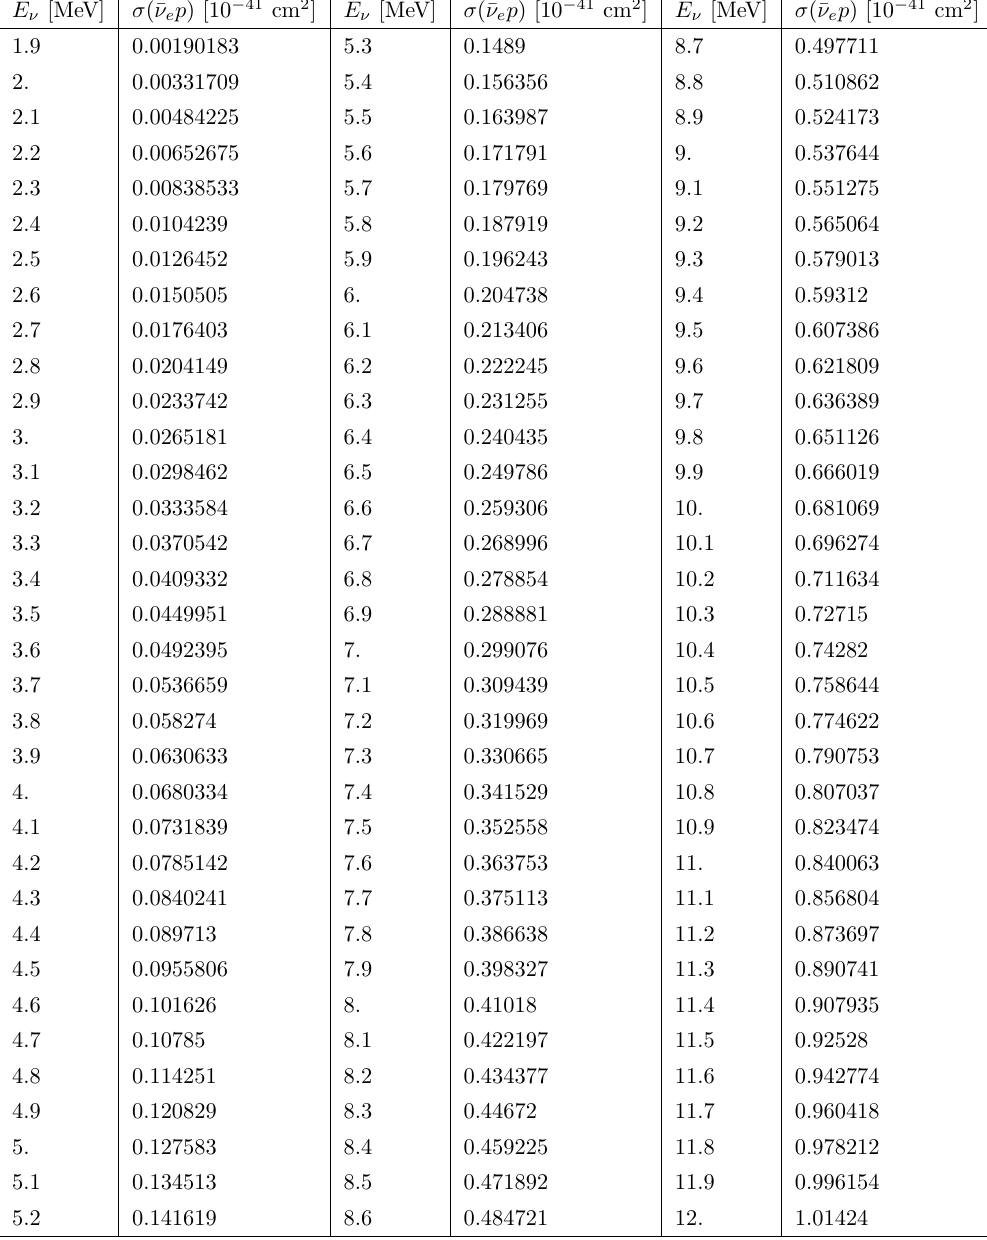
Table 4 . Numerical values (in the hyper-conservative case) for the IBD ¯ ν e p → e + n cross section as function of the neutrino energy in the low energy